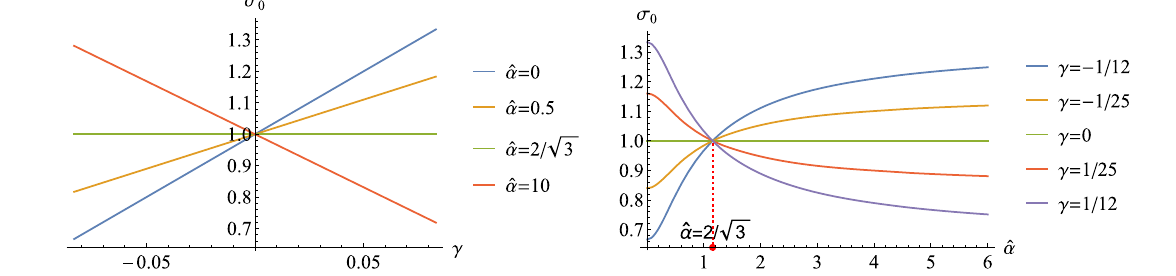
Fig. 5 Left plot: the DC conductivity σ 0 versus the Weyl coupling parameter γ for some fixed dissipation constant ˆ α . Right plot: the DC conductivity σ 0 versus the dissipation constant ˆ α for some fixed Weyl